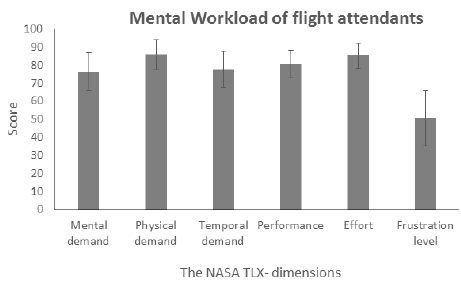
Figure 1. Mental workload of flight attendants